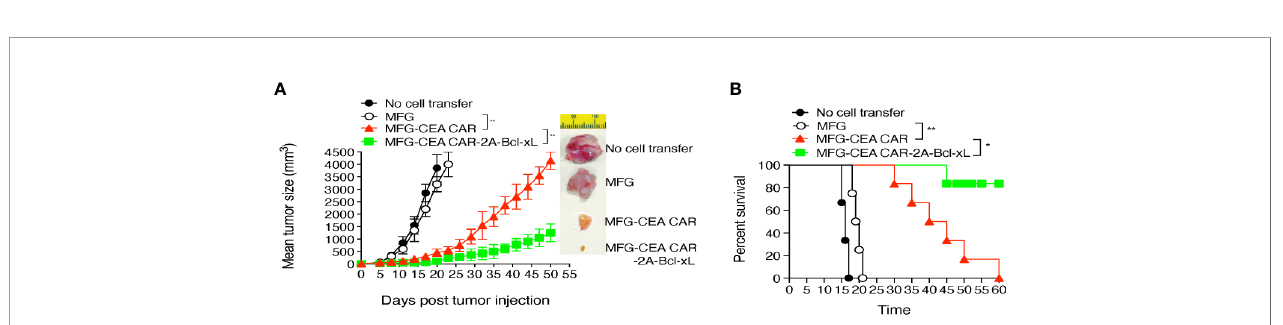
FIGURE 7 | Adoptive cell transfer of carcinoembryonic antigen (CEA) chimeric antigen receptor T (CAR-T) cells expressing Bcl-xL substantially suppressed tumor growth and sustained mouse survival. The tumor challenge and the adoptive cell transfer are described in Figure 6 . (A) Tumor growth was monitored over time with representative tumors on day 18. Data are mean tumor size ± S.D. from six individual mice (n=6) and representative of three experiments. (B) Mouse survival was assessed over 60 days (Kaplan – Meier survival analysis). *P < 0.05, **P < 0.01, Student ’ s unpaired